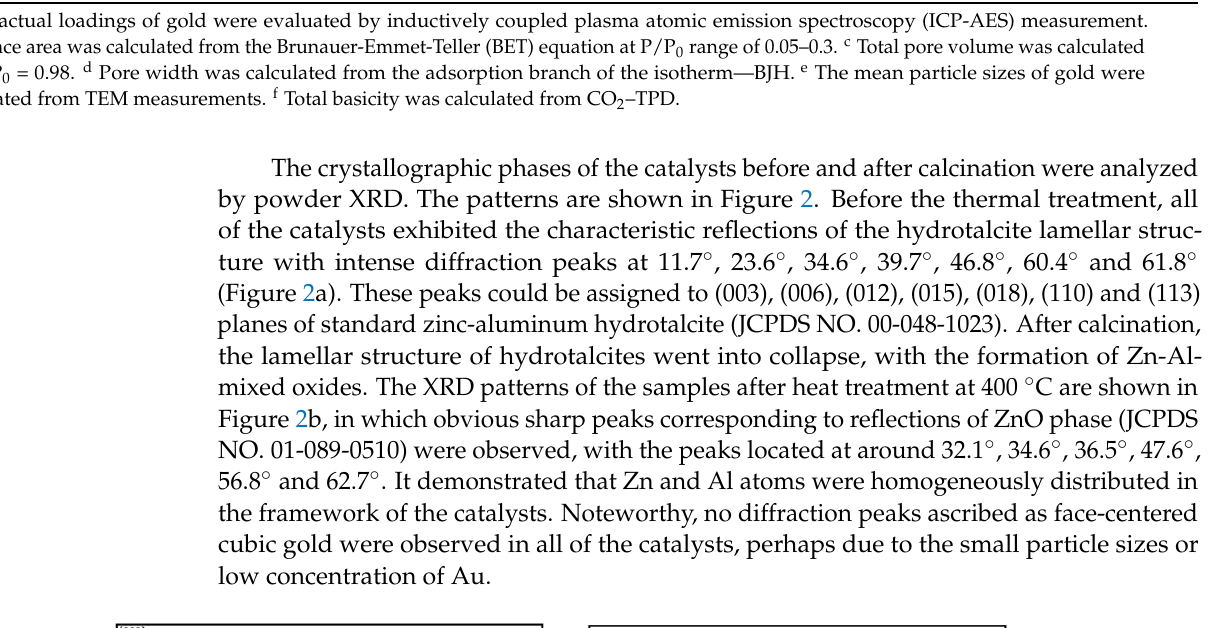
Table 2. Textural properties of Zn-Al-mixed oxides supported gold nanoclusters.